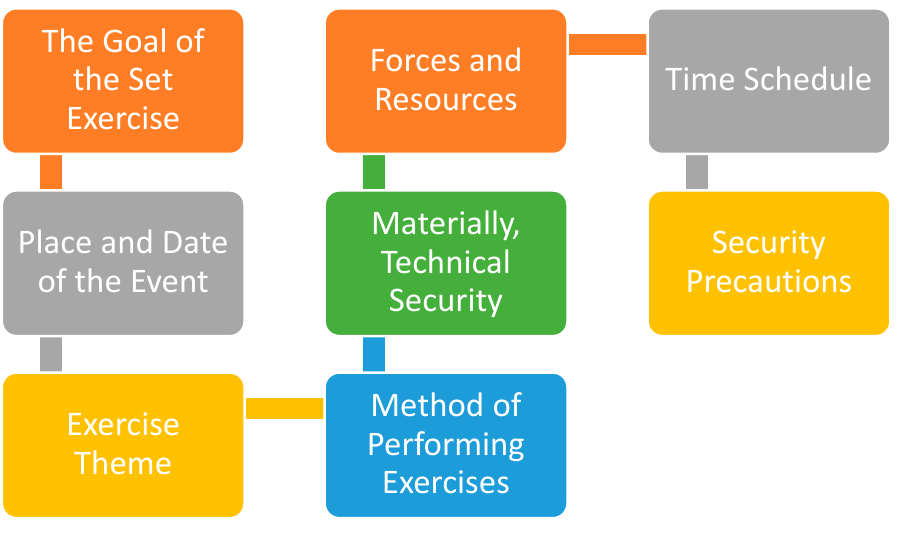
Figure 1. Exercises plan. Figure 2. Exercises